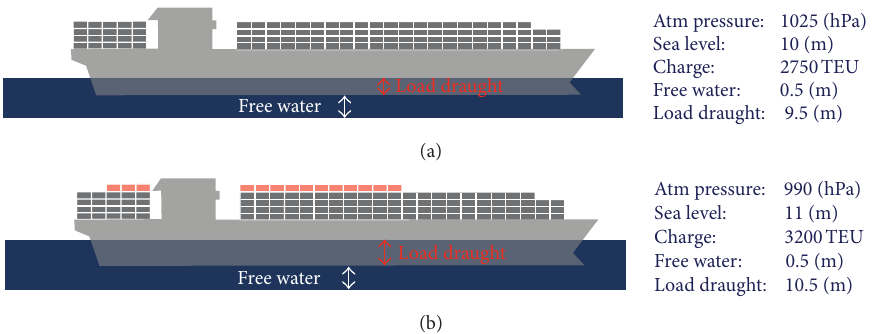
Figure 11: Difference of payload in TEU during two different atmospheric pressure situations.